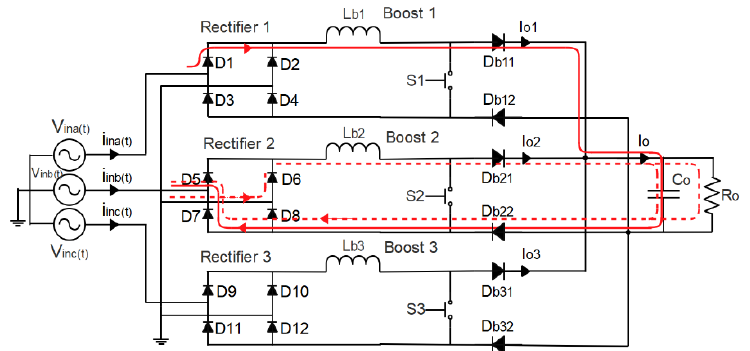
Figure 4. Second interaction of current traveled in phase a.